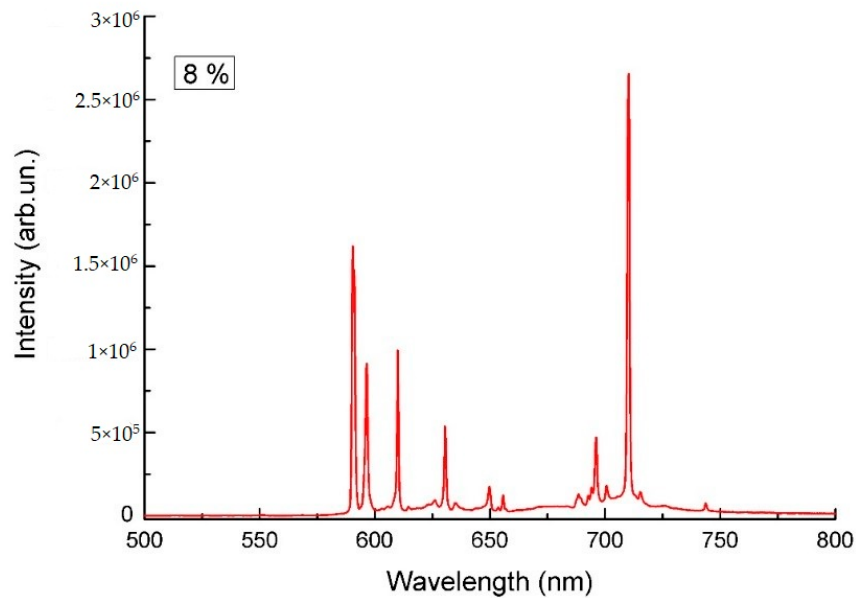
Figure 12. The photoluminescence spectra of YAG:Eu (8%).